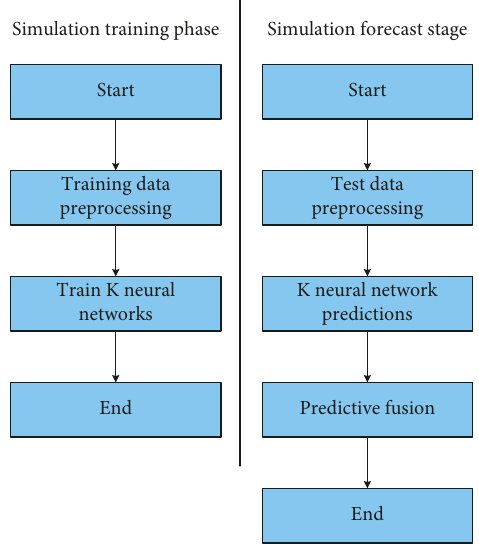
Figure 6: A predictive model of rural finance based on artificial neural